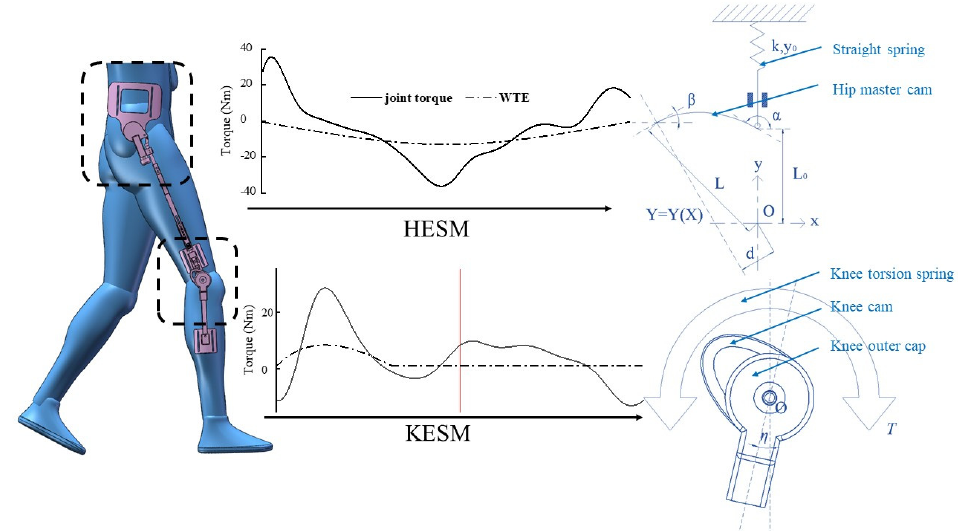
Figure 3. Mechanism schematic diagram of the HESM. We bring L = 30, β = 0, L 0 = 20, and α into Equation (1) and simplify the equations to obtain Equation (2). initial spring compression, the slope of the cam curve at the initial point, the slope of the cam curve at the end point, the force arm of the cam, the radius of the cam base circle, and